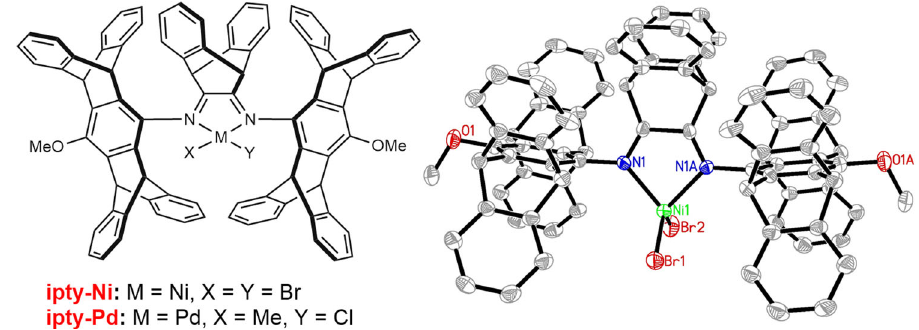
Fig. 2 Sterically constrained catalysts of ipty-Ni and ipty-Pd and the molecular structure of ipty-Ni. ipty-Ni and ipty-Pd are prepared by the reaction of α - diimine ligand with NiBr 2 (DME) and PdMeCl(COD), respectively. Table 1 Effect of temperature and pressure on branching in ethylene polymerization with ipty-Ni a